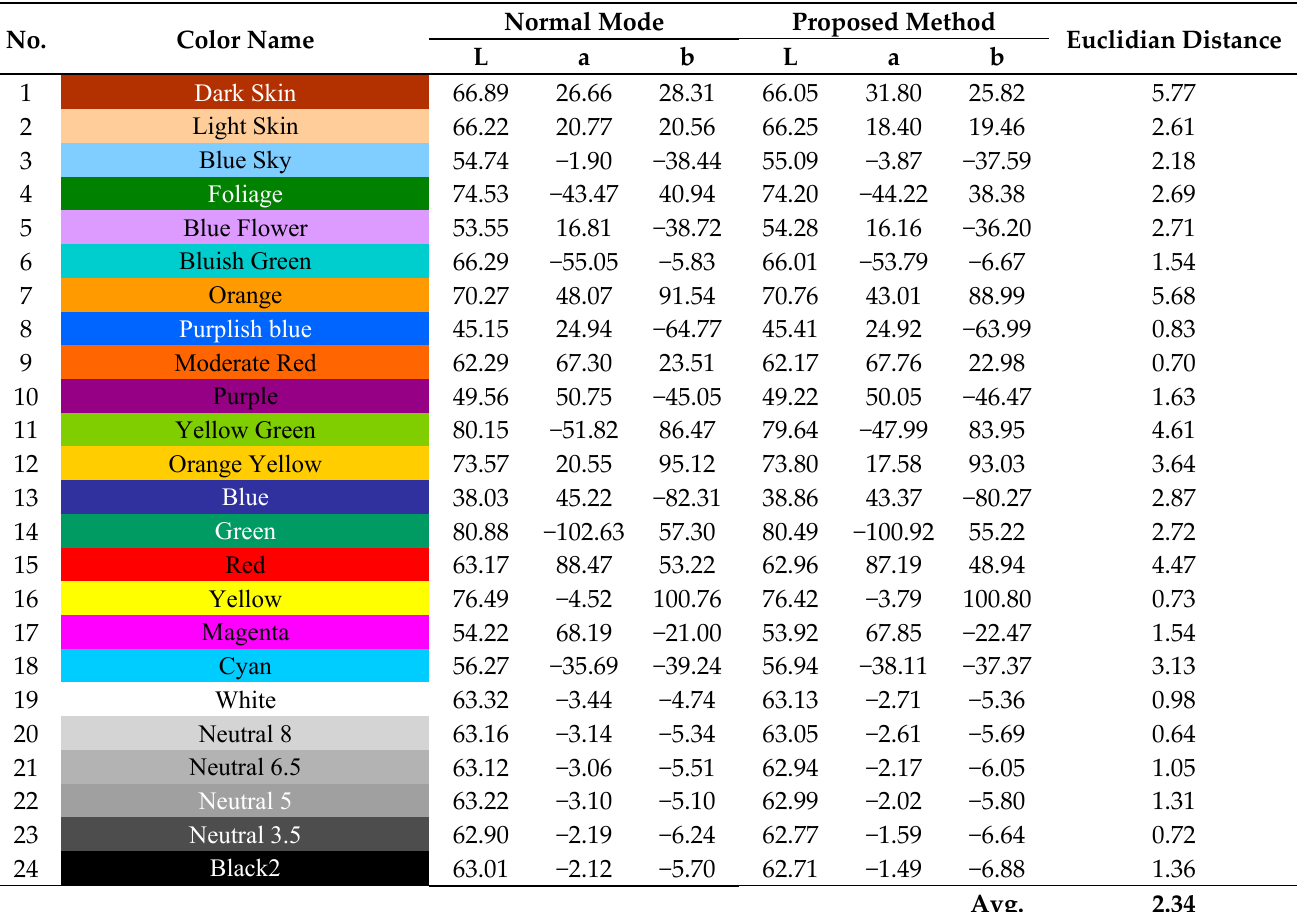
Figure 6. Macbeth chart for color distance between colors of normal mode and colors of proposed method.